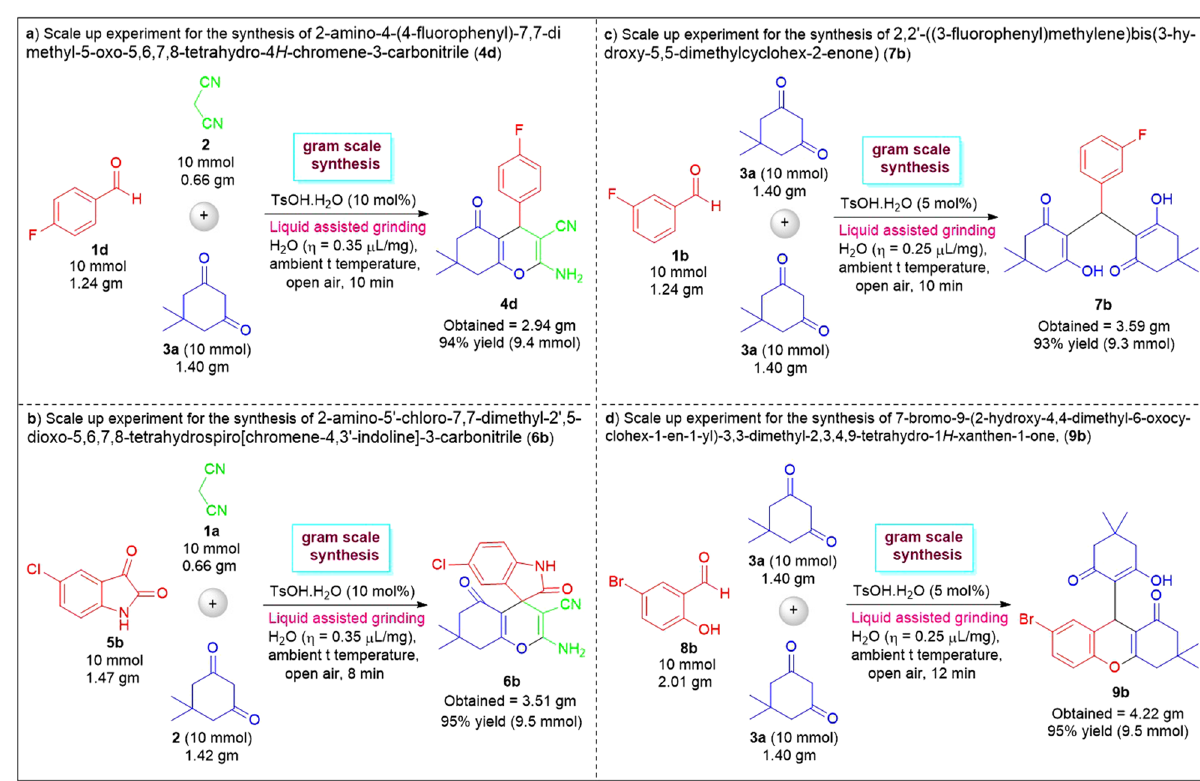
Figure 10. Preparative gram scale experiments for the synthesis of 4d , 6b , 7b , and 9b